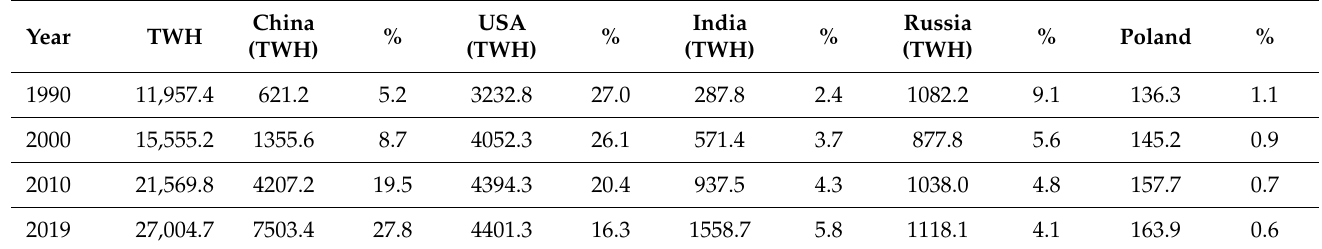
Table 1. Electric energy production in the world in